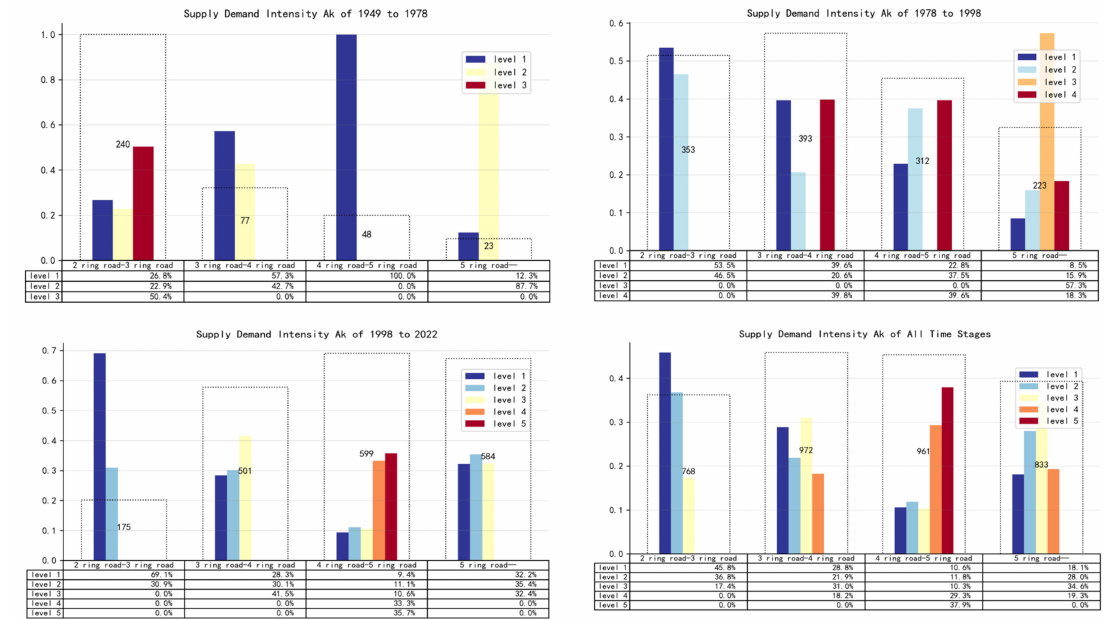
Figure 7. Measurement results of the 2SFCA